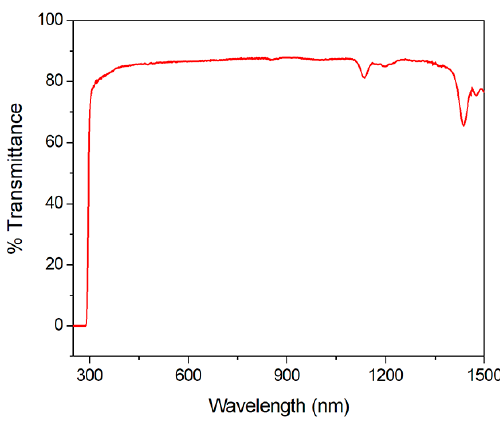
Figure 5. Transmission spectrum of the TPPB (2H 2 O) single-crystal with a thickness of 0.5 mm.